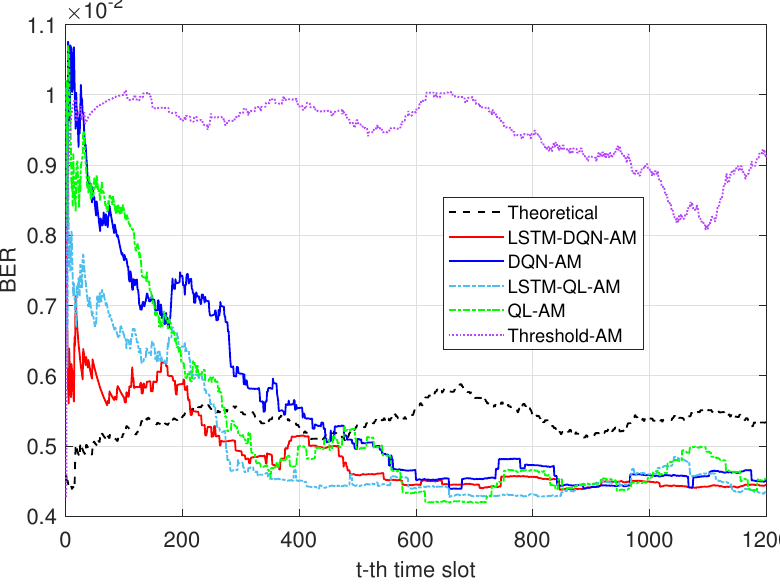
Figure 14. The BER of the AM schemes in the sea experiments.